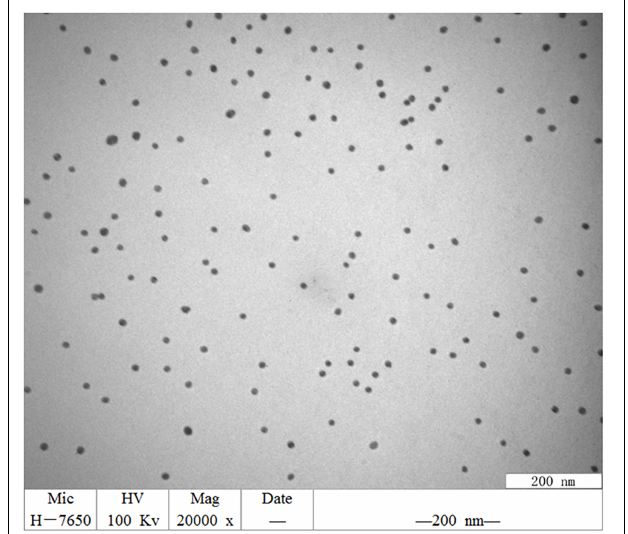
FIGURE 1 | TEM image of GNPs synthesized. GNPs had a relatively regular size and spherical morphology, uniform particle size, no impurity fragments, and no agglutination.